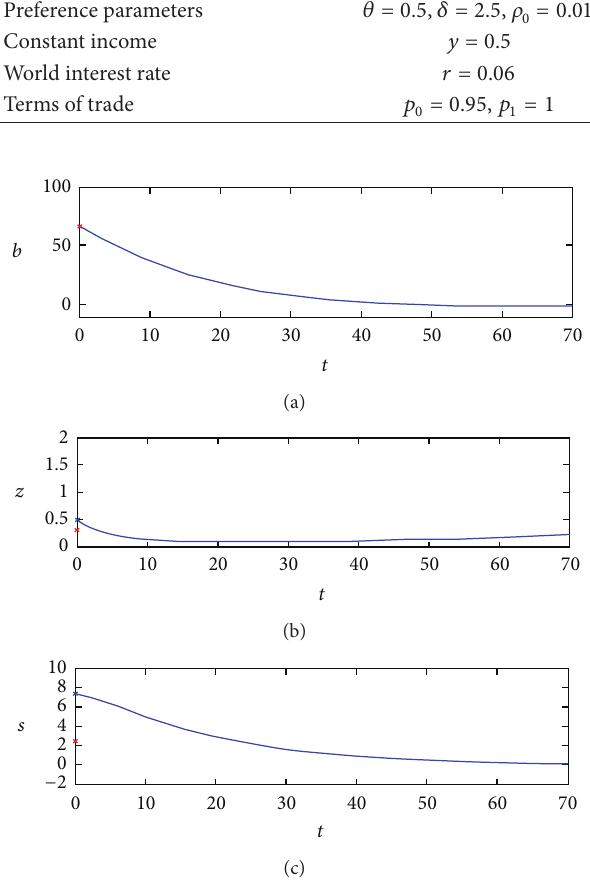
Figure 5: Time evolutions of bond holdings, consumptions, and